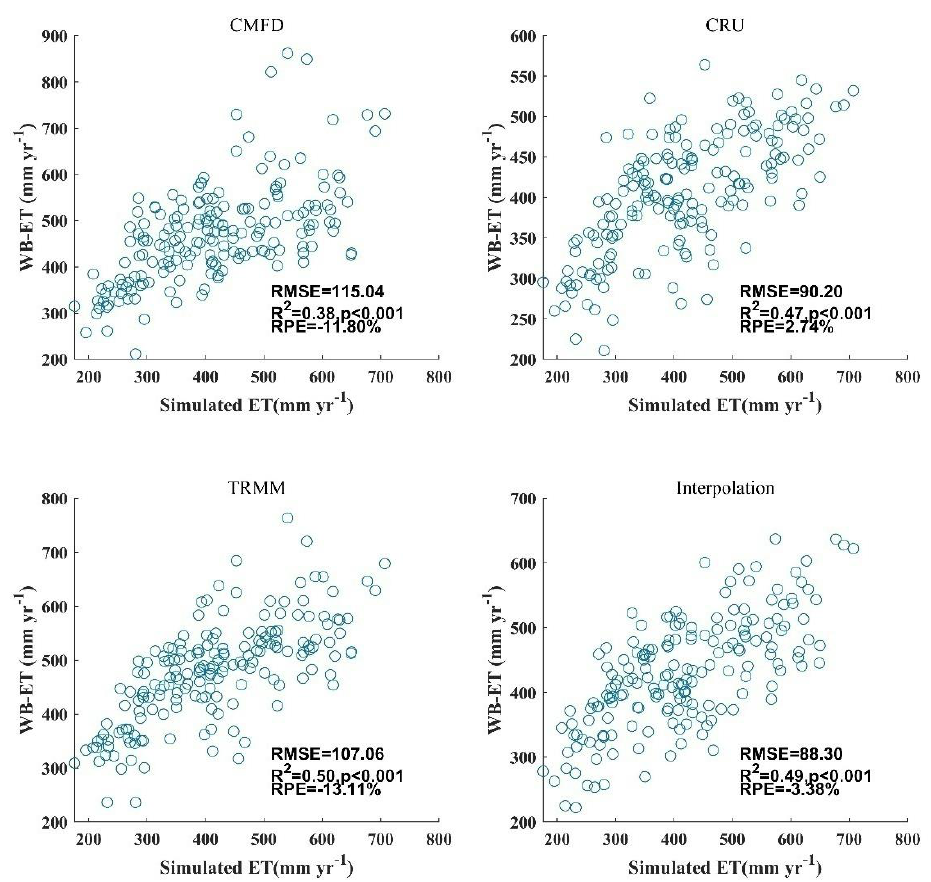
Figure 9. Evaluation of ET SSEBopYRB using water balance ET derived from four precipitation products during the years 2003–2015. The dotted line is the 1:1 line and the blue line is the fitted line between observed values.